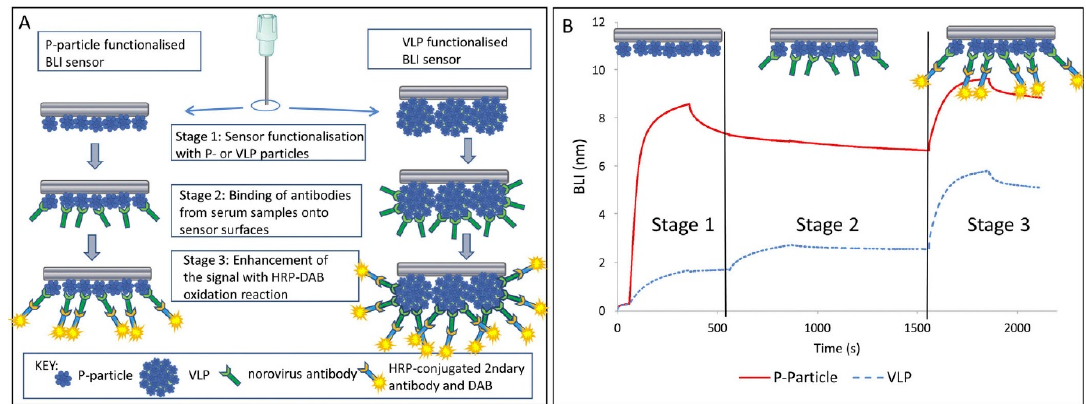
Figure 3. Detection of norovirus-like particles (VLPs) using the biolayer interferometry (BLI) based biosensor method. ( A ) Schematic representation of the BLI detection method utilizing NoV VLP or P-particles functionalized sensor. ( B ) Sensorgrams of a NoV-positive serum sample. The red and blue curve correspond to the NoV P-particle and VLP functionalized sensor, respectively. (Reprinted from Auer et al. [145] with permission from the publisher).